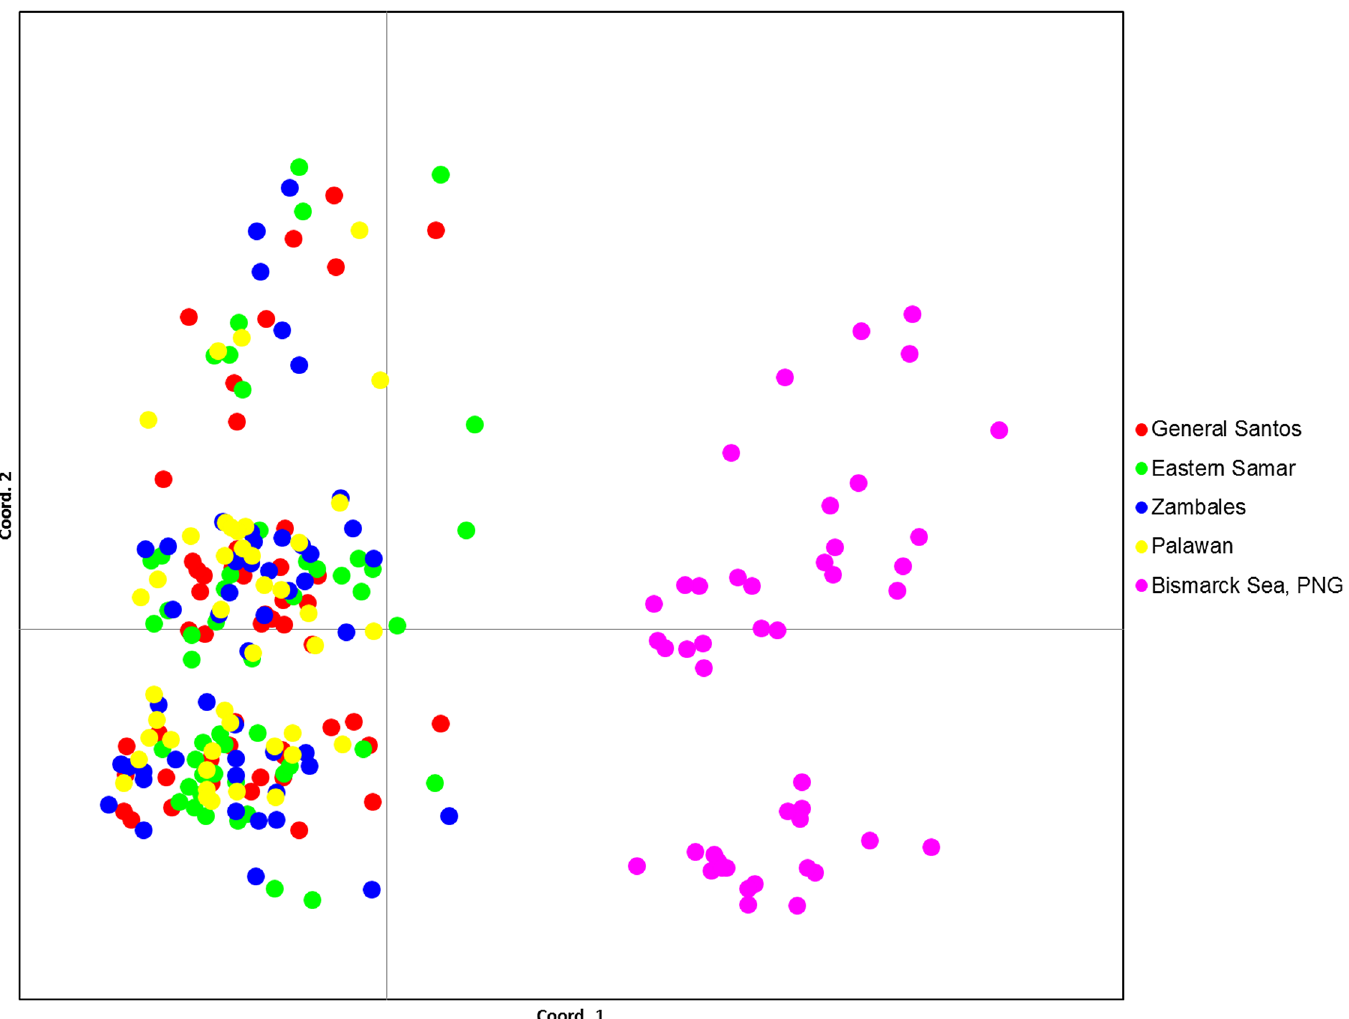
Fig 2. Principal Coordinates Analysis of T . albacares exhibiting two separate clusters based on district matrix using nine DNA microsatellite loci. Red – General Santos; Green – Eastern Samar; Blue – Zambales; Yellow – Palawan; Purple – Bismarck Sea, Papua New